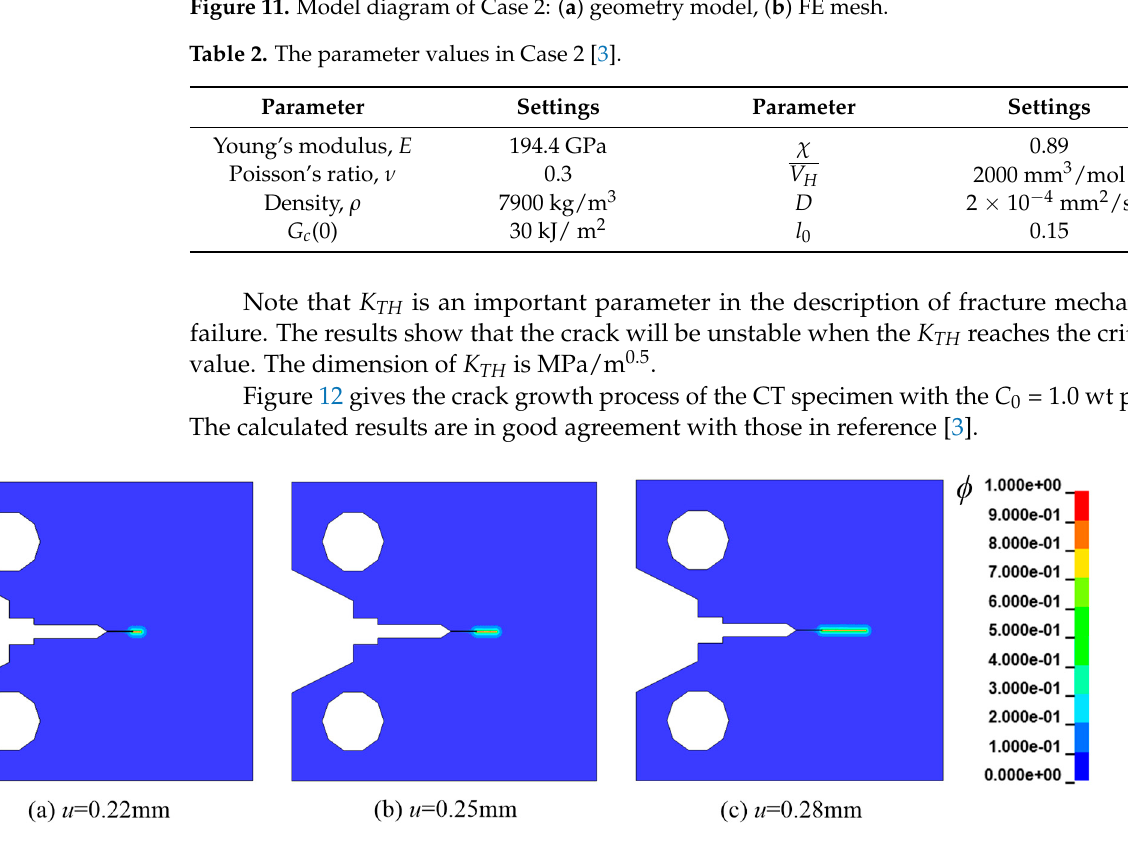
Figure 12. Crack growth process of CT specimen.